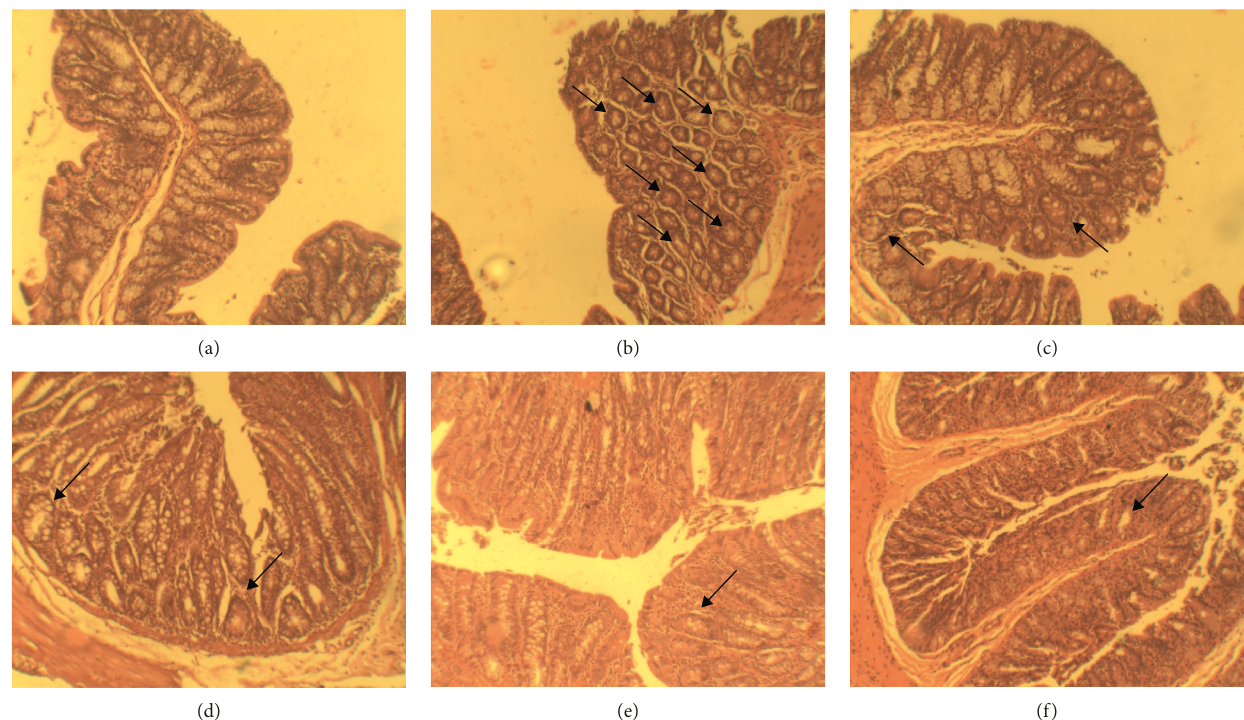
Figure 8: Histopathological changes of colon tissues from different treatment groups at 40x magnification. Arrows indicate aberrant crypt foci. (a) Normal control; (b) DMH control; (c) 5-FU; (d) quercetin; (e) QMJ-2; (f)